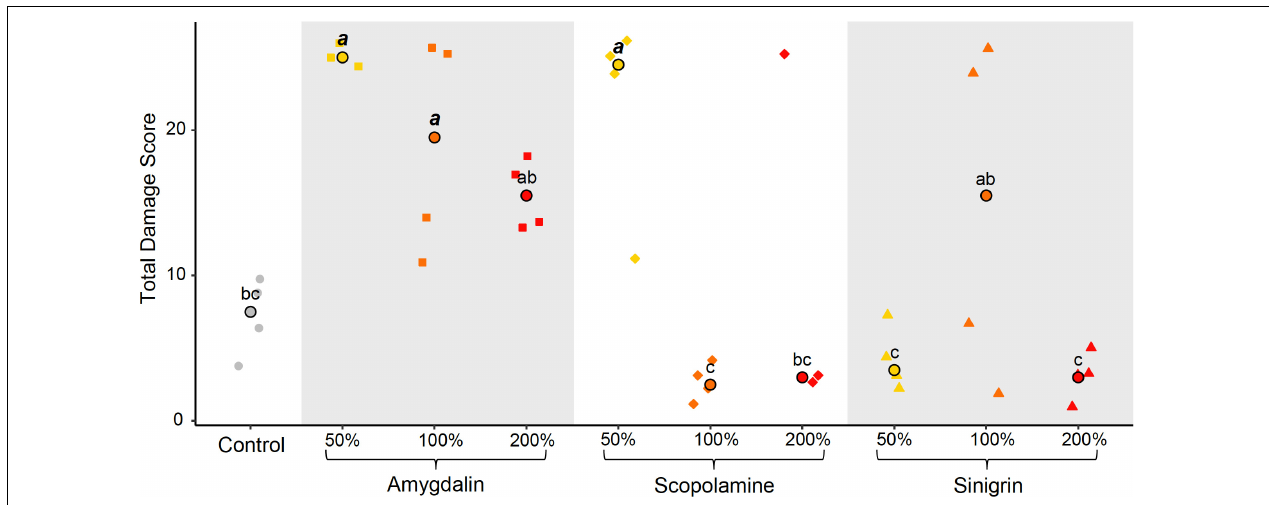
FIGURE 2 | Individual and median total damage scores. The dot-plot shows the total damage scores obtained in 38 individual tissue samples from the ten different diet treatments. Different letters indicate significant differences ( p < 0.05) between diet treatments. Scores significantly higher than control are depicted in bold italic.